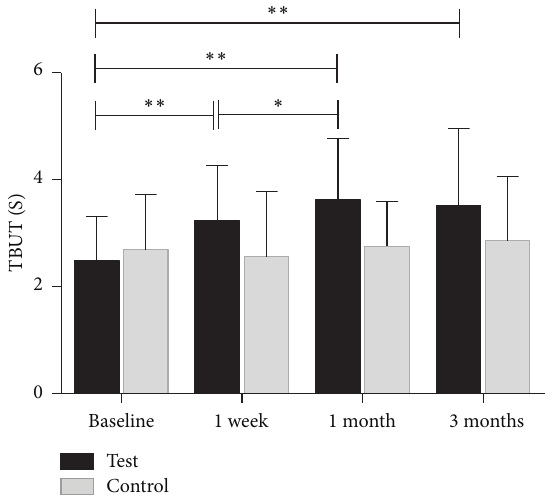
Figure 5: The mean value of test-eye tear breakup time (TBUT) measuredatbaseline,atoneweek,atonemonth,andatthreemonths ( ∗ 𝑝 < 0.05 , ∗∗ 𝑝 < 0.001 ).